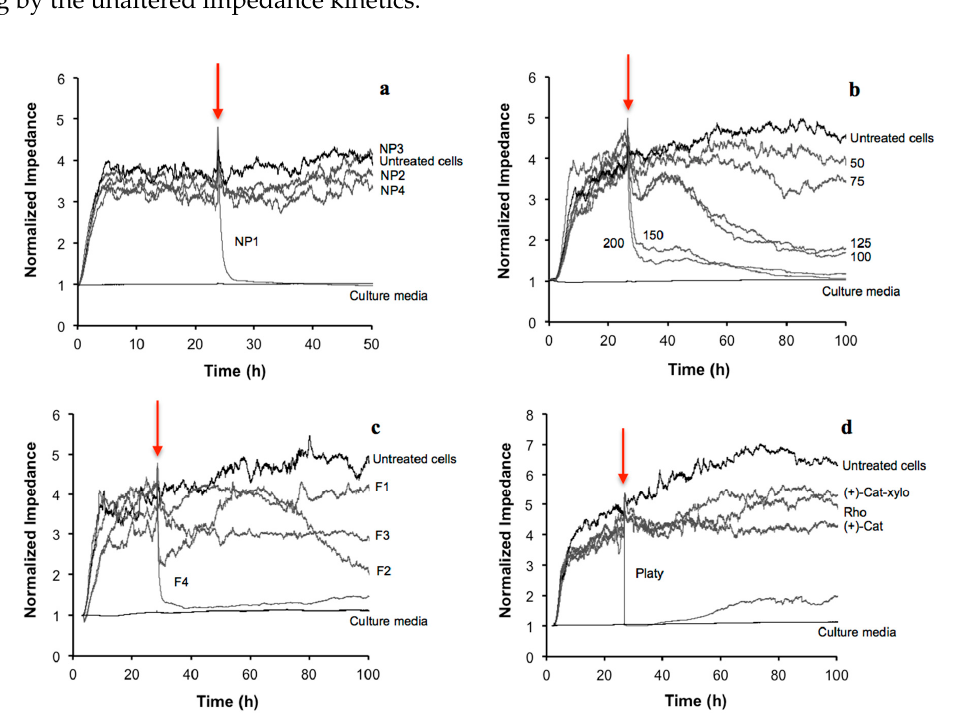
Figure 2. Impedance changes recorded with ECIS in cells treated with ( a ) birch (NP1), milk thistle (NP2), olive (NP3), and propolis (NP4) extracts (all at a concentration of 0.5 mg/mL); ( b ) birch extract, NP1 (at a concentration range of 50–200 µ g/mL); ( c ) fractions F1, F2, F3 and F4 from NP1 (50 µ g/mL) (see Experimental Section); and ( d ) pure compounds present on the fractions F1, F2 and F3 of NP1 at fraction concentrations of 50 µ g/mL (platyphylloside 65.6 µ M; rhododendrin 26.3 µ M; (+)-catechin 7- O - β - D -xylopyranoside 24.7 µ M; and (+)-catechin 35.9 µ M). The red arrows indicate the time points where the samples were added for cytotoxicity assessments. Abbreviations used in the figure and legend: (+)-Cat corresponds to (+)-catechin; (+)-Cat-xylo corresponds to (+)-catechin 7- O - β - D -xylopyranoside; Rho corresponds to rhododendrin and Platy corresponds to platyphylloside.